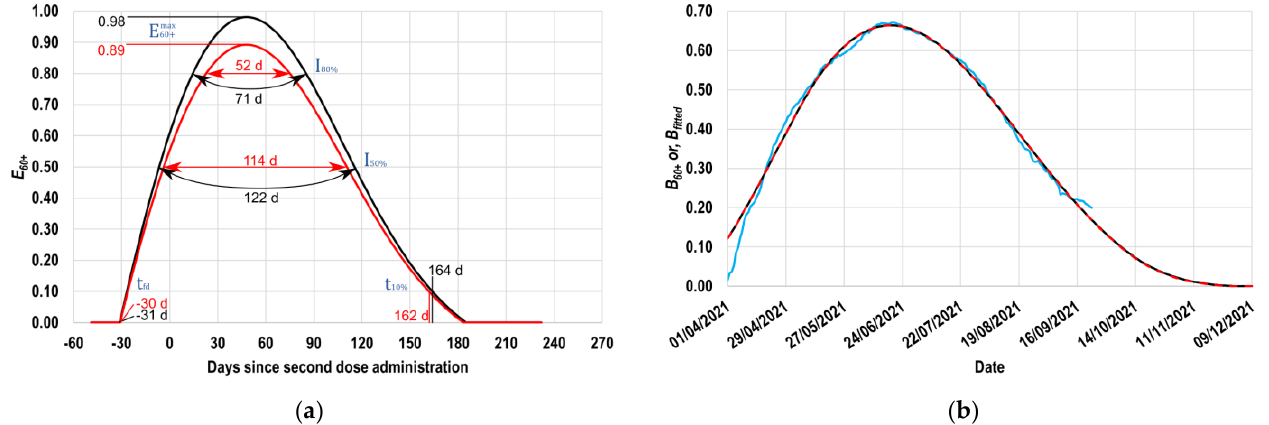
Figure 4. Results obtained with the proposed methodology, considering the officially published real-time vaccination profile (black curves) or assuming an underestimation of 10% in such a profile (red curves). ( a ) 𝐸 60+ profiles. ( b ) Real-world 𝐵 60+ smooth profile (blue curve) and fitted profiles ( 𝐵 𝑓𝑖𝑡𝑡𝑒𝑑 ).